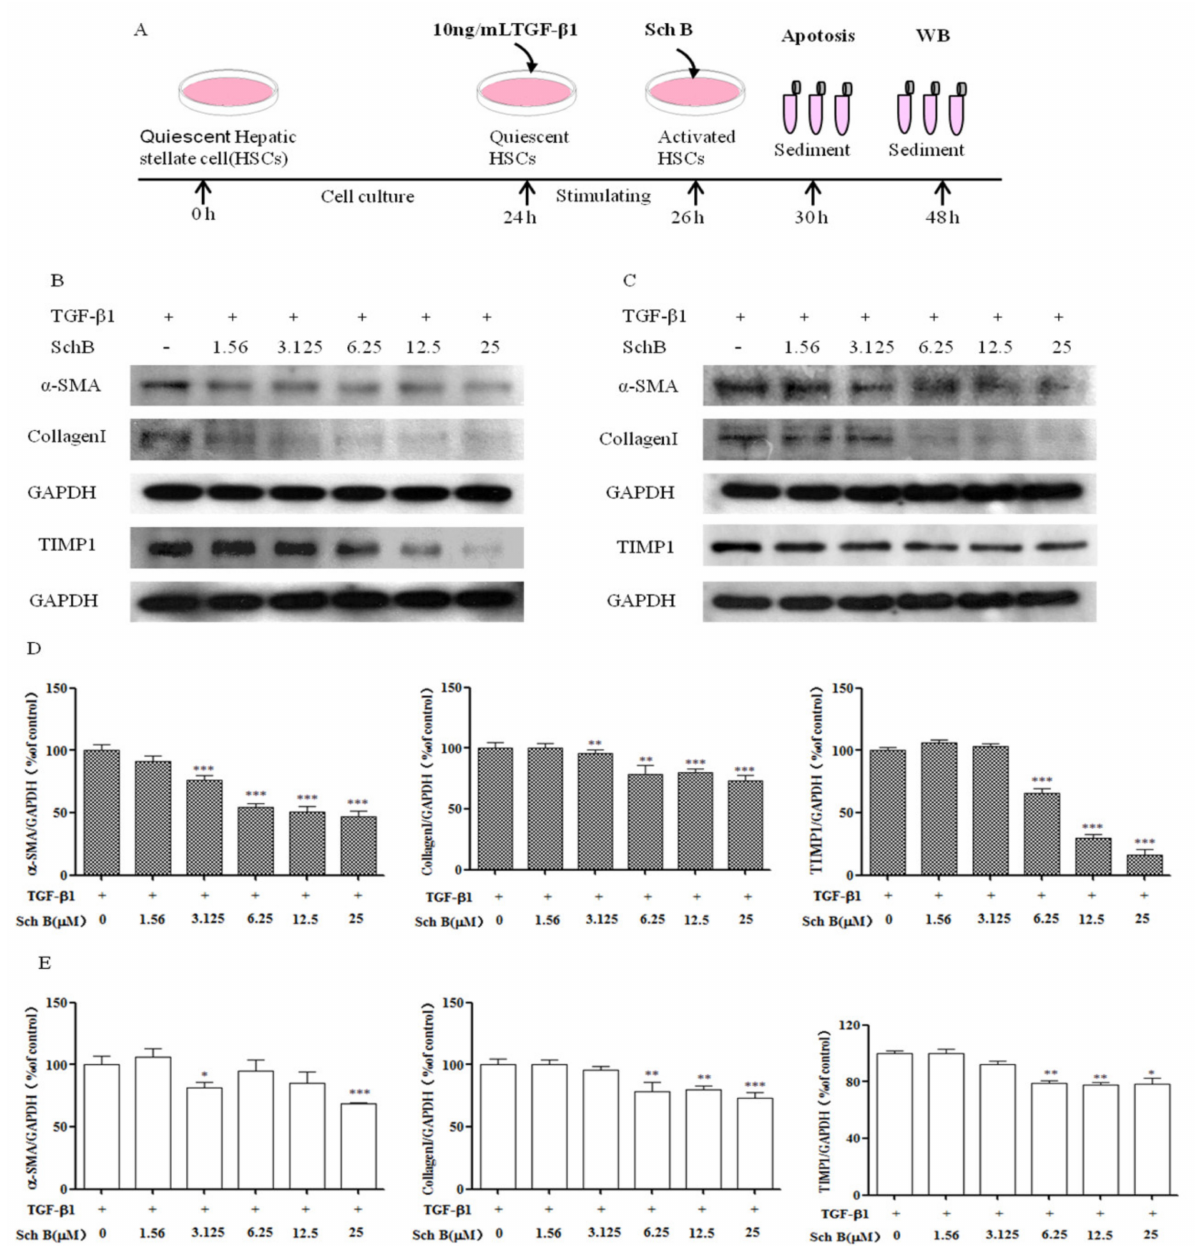
Figure 2. Identification of the Sch B anti-fibrotic effect in vitro. ( A ) Schematic representation of the experimental schedule. Alterations of Sch B on the expression of profibrotic proteins levels of α -SMA, TIMP-1, and Collagen I were determined by western blotting. Sch B suppressed the expressions of α -SMA, Collagen I and TIMP-1 in a dose-dependent manner in ( B ) HSC-T6 cells and ( C ) LX-2 cells. ( D ) Densitometric analysis of α -SMA, TIMP-1, and Collagen I of HSC-T6 cells. ( E ) Densitometric analysis of α -SMA, TIMP-1, and Collagen I of LX-2 cells. The values are expressed as the mean ± SD. * p < 0.05, ** p < 0.01, *** p < 0.001 compared with the TGF- β 1